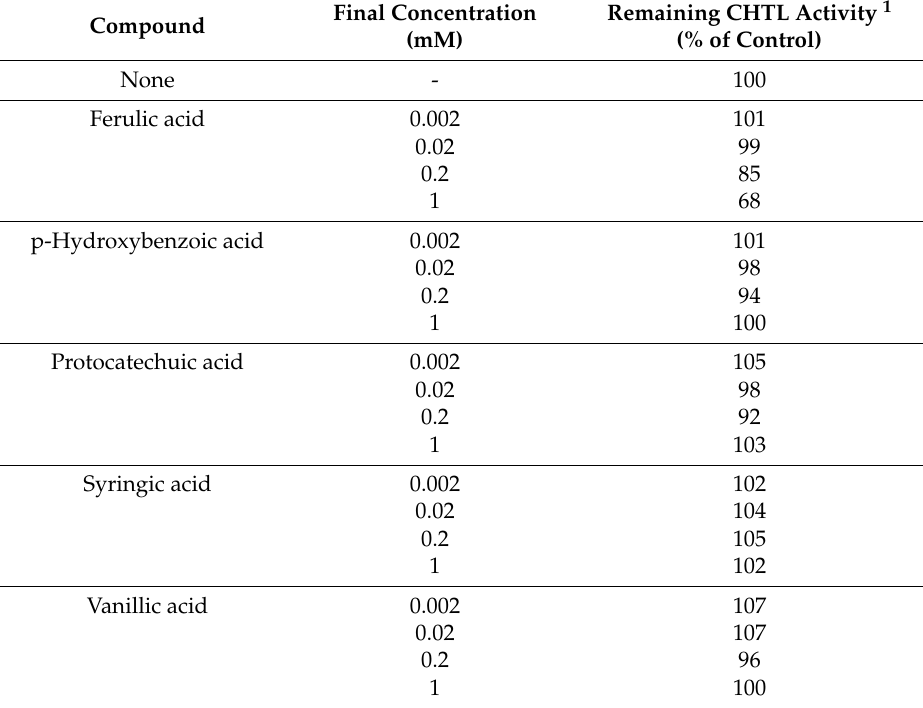
Table 1. In vitro e ff ect of various phenolic acids on chymotrypsin-like activity of T. versicolor